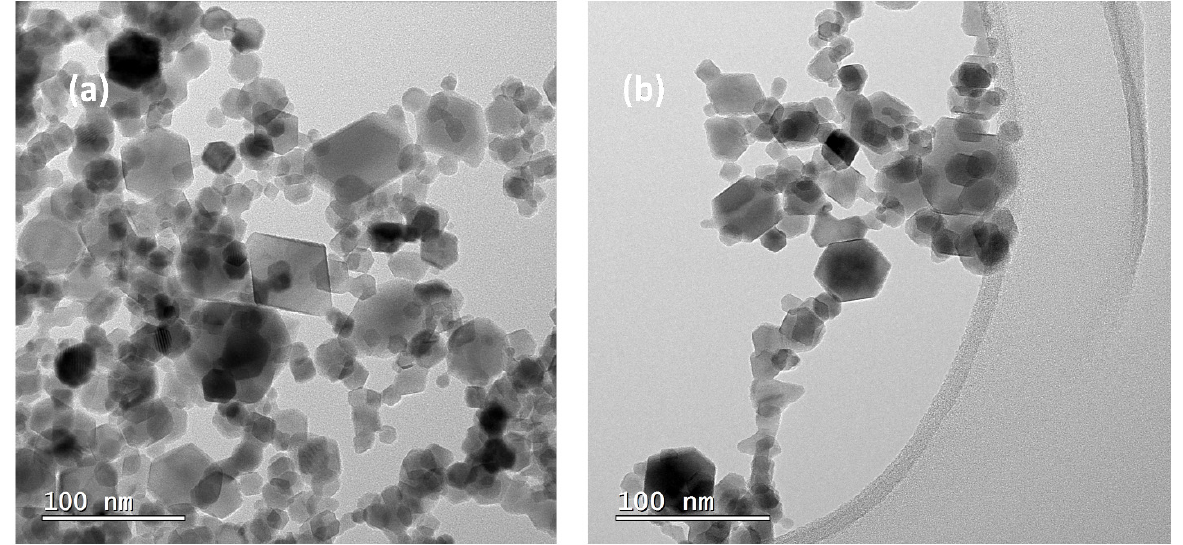
Figure 4. HRTEM images of ( a ) NZF@NF ( b ) and NZF.